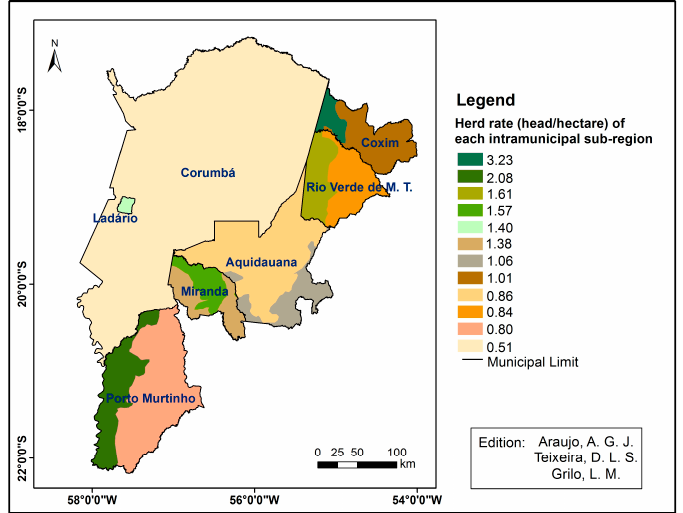
Figure 6. Pasture stocking rate by intra-municipal subregions of the South Pantanal. Sources: (2018). However, the adaptive condition of land use according to the annual pulse of floods makes it difficult to adopt a single management plan for wetlands and even for properties. This variation in the carrying capacity of a pasture prevents a fixed stocking rate for large area units. As a solution, the authors propose the mapping of landscape units that recognize temporary elements of the landscape (which flood at some times of the year, such as bays and ebb), greater attention to the size of each landscape unit and the variation of the support capacities of each type of vegetation, associated with the extent, intensity and frequency of annual floods [36]. Table 2 shows the destination of the flows of the animals that left the South Pantanal between 2007 and 2014. Clearly, it is possible to perceive that most remained in the pantanal wetlands; more than 6,300,000 cattle. As a complement and revealing the articulation between the plain and plateau areas in the BAP, 10.15 million heads were moved to the plateau, of which 4.2 million were sent to the plateau sub-regions of the seven municipalities (41%) and 5.95 million (59%) for other municipalities in the Basin. Table 2. Number of cattle moved from the South Pantanal in the period from 2007 to 2014, according to the origins and the destinations (units). Municipality and Sub-Region of Origin